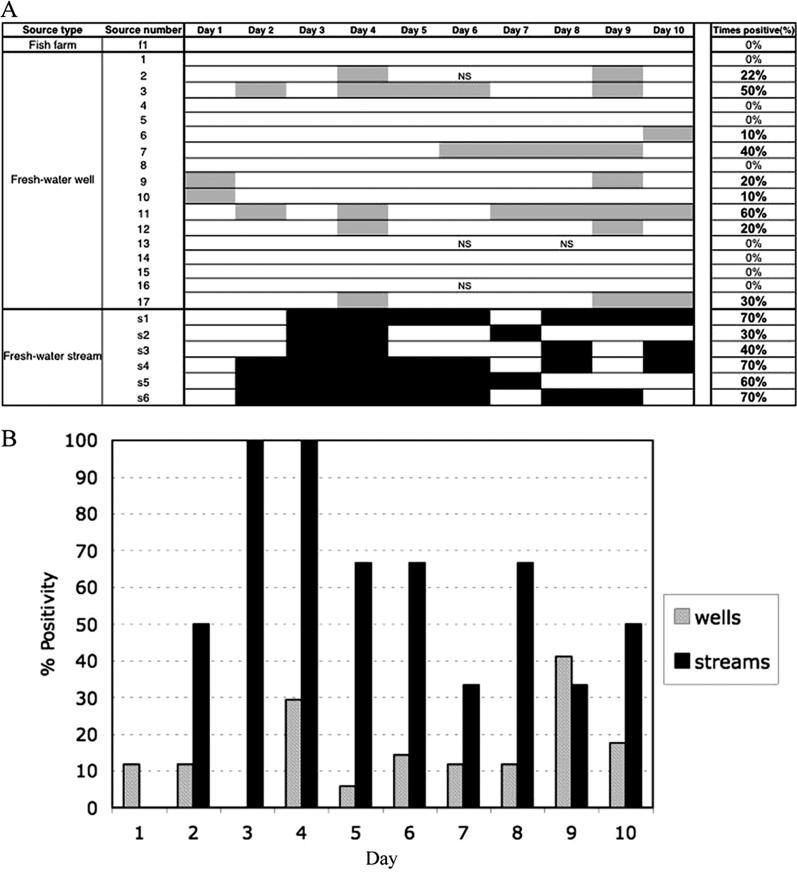
Padrecocha Sequential SamplingA total of 17 wells and six stream sampling points were tested over time. Filled boxes indicate PCR-positivity on that day (A). Bars indicate percentage of positivity of wells and stream sampled points for each tested day (B). The streams had a statistically significant higher frequency of positivity over time than the wells (χ2 = 133.74, p < 0.001). NS, not sampled.